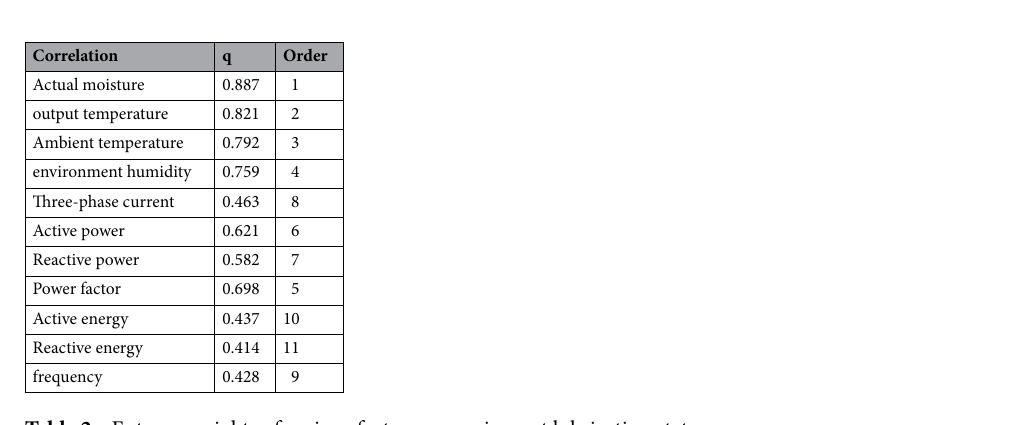
Table 2. Entropy weights of various factors on equipment lubrication